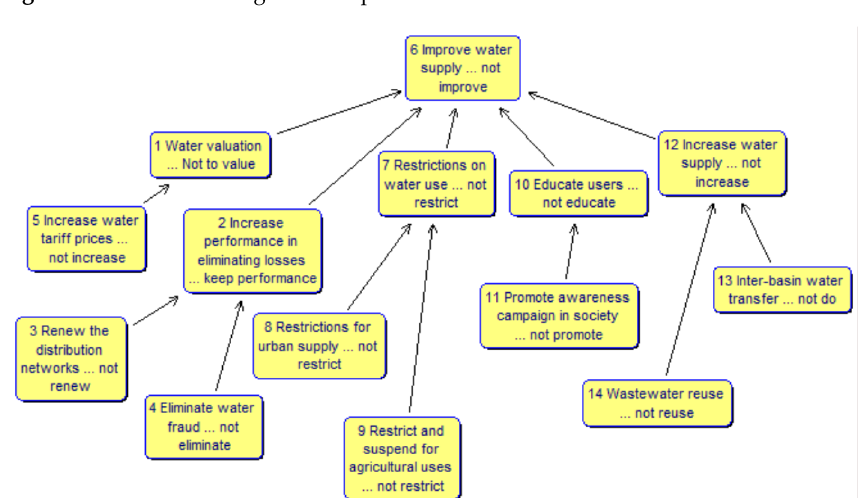
Figure A2. Individual Cognitive Maps of Actor B.